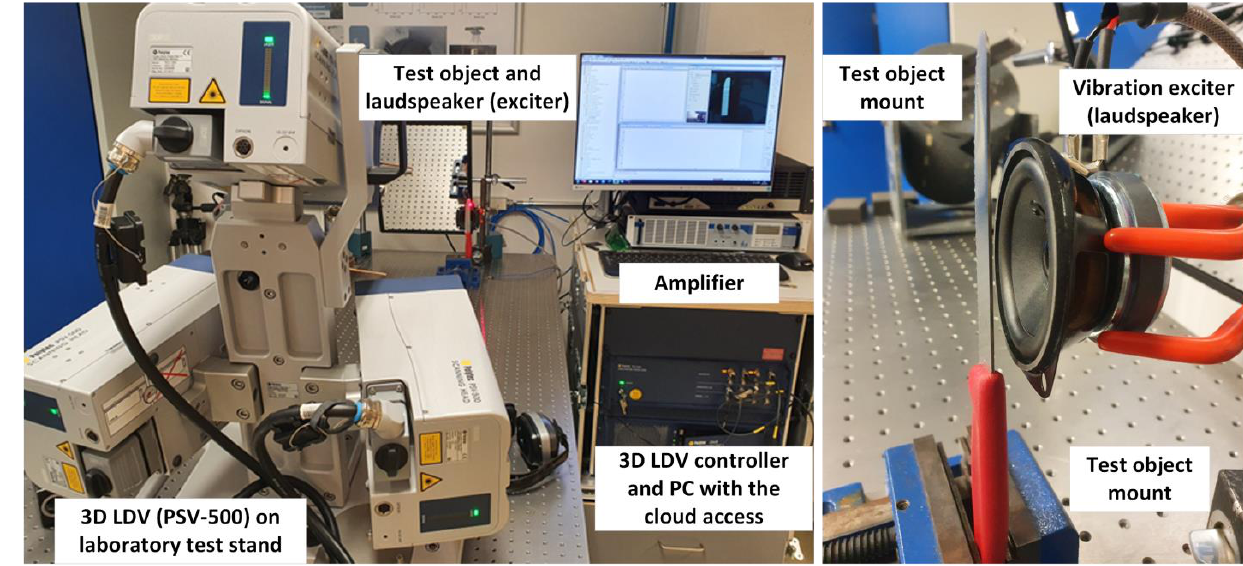
Figure 4. Illustration of experimental arrangement for a measurement.